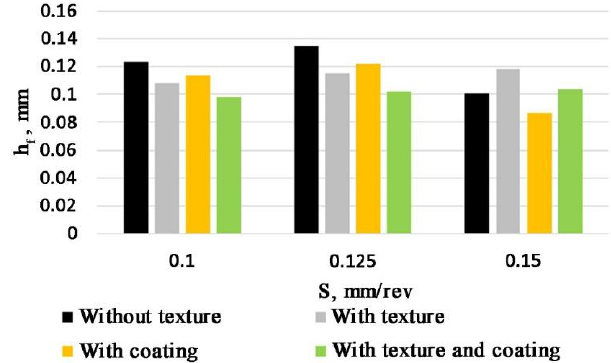
Figure 13. The wear on the flank surface on different feed per revolution values dependent on various tools at a cutting speed V = 17 m/min and t = 0.4 mm.